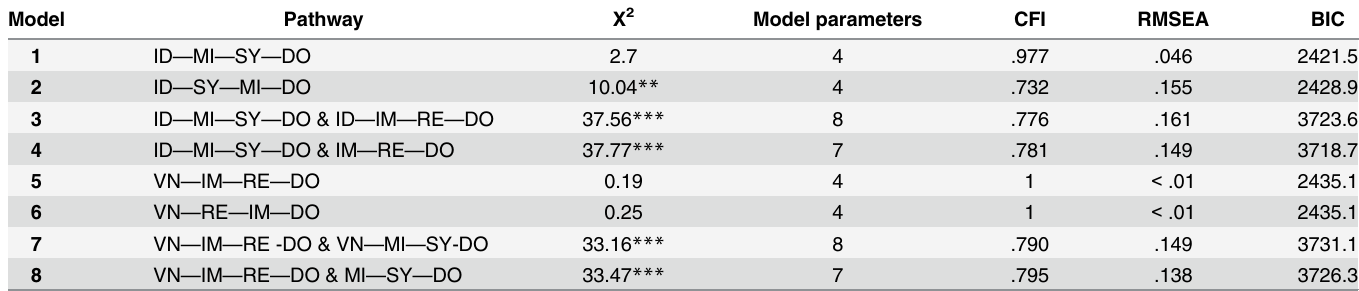
Table 3. Model Fit for Path Analyses, Study